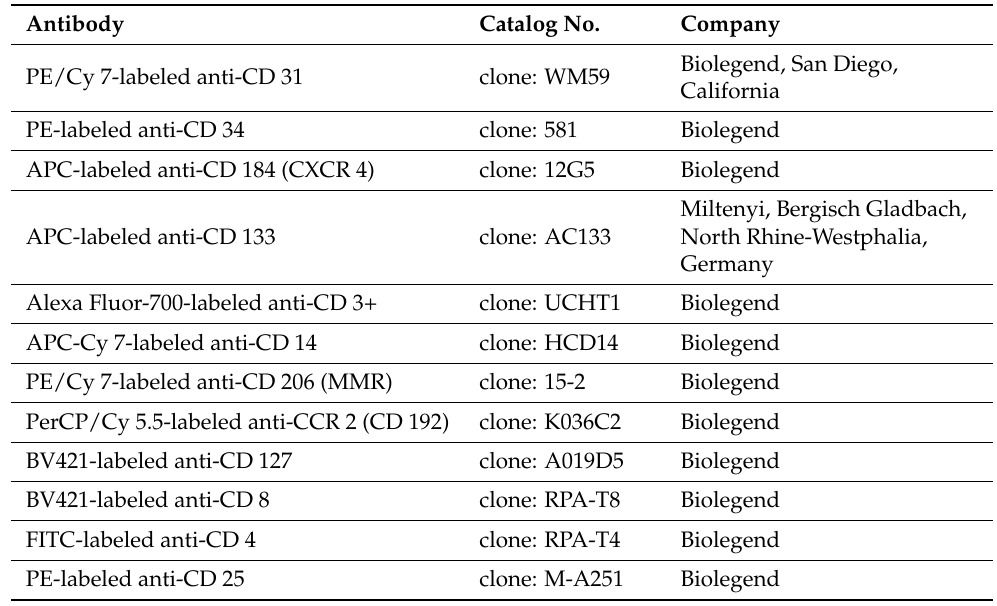
Table 2. Antibodies for flow